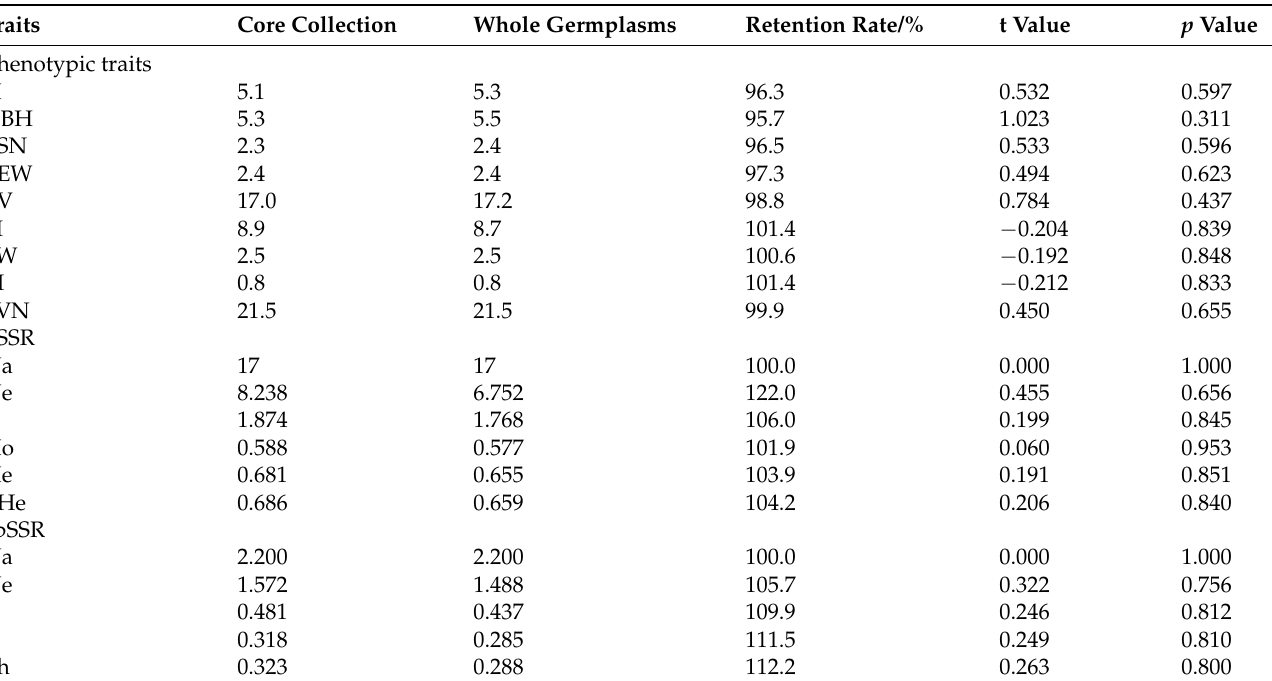
Table 4. Comparison of phenotypic trait and genetic diversity between the core and raw locust